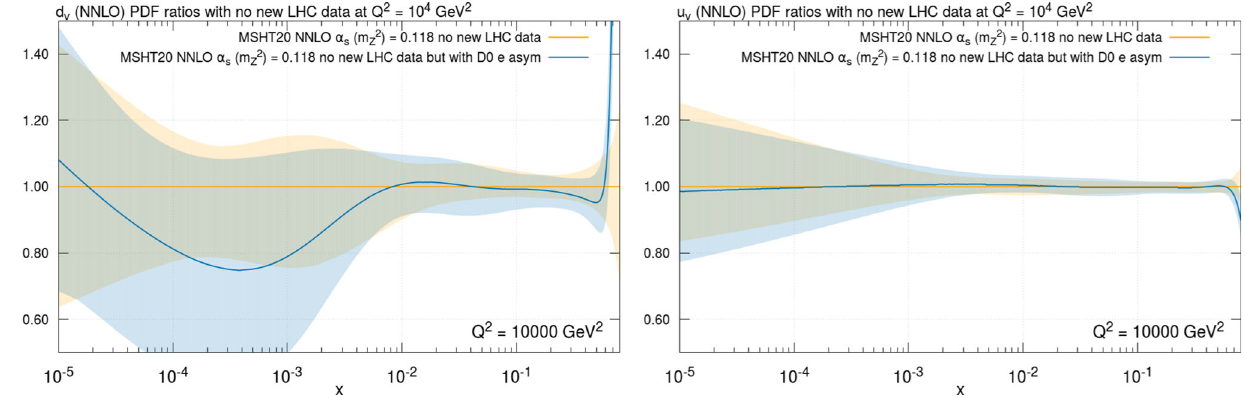
Fig. 59 (Left) d V PDF and (right) u V PDF ratios to the MSHT20 default at Q 2 = 10 4 GeV 2 at NNLO without any new LHC data included, showing the effect of including the DØ data as an electron asymmetry rather than the W asymmetry